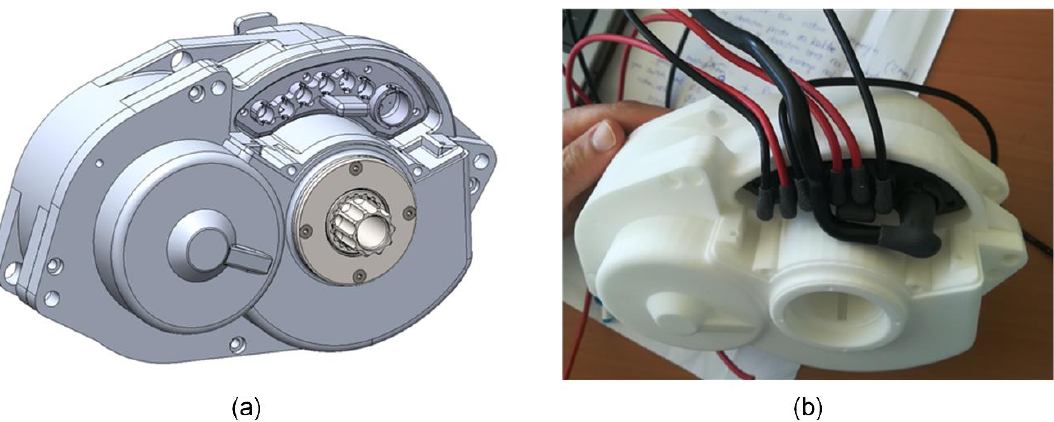
Figure 6. Prototype B1: ( a ) virtual prototype; ( b ) a 3D printed prototype B1 to test space for connect- ors.